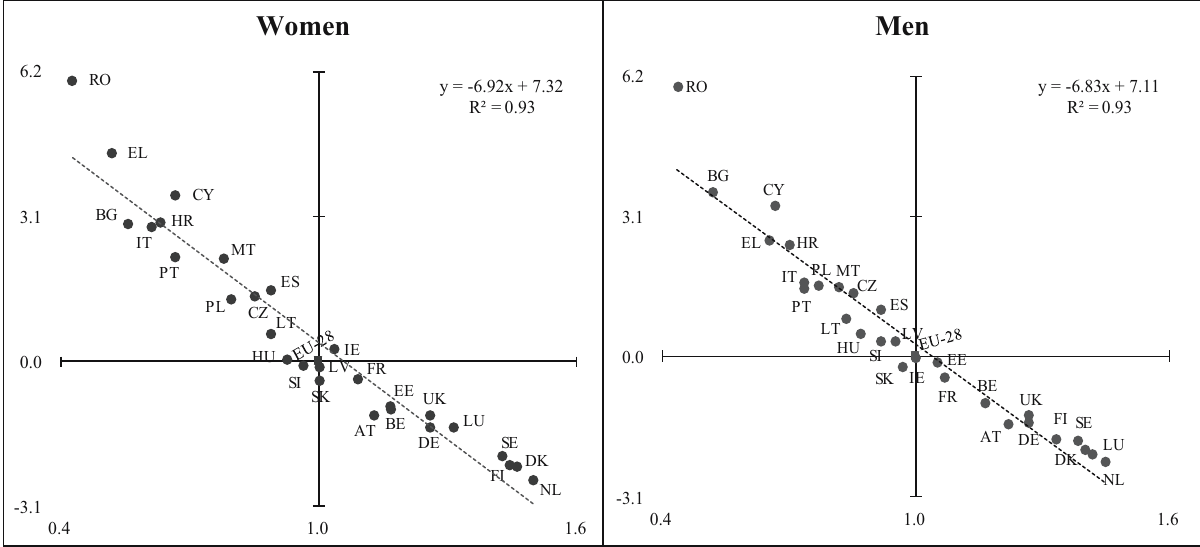
Figure 2: β - convergence in Internet use in the EU - 28, 2007 – 2019. Note: The abscissa represents the relative situation of women and men with respect to the EU - 28 ( which represents the unit ) in the 2007 ICT - USE indicator. The average annual growth di ff erential with the EU between 2007 and 2019 is represented on the ordinate. Source: Own elaboration from Digital Economy & Society Database ( Eurostat )